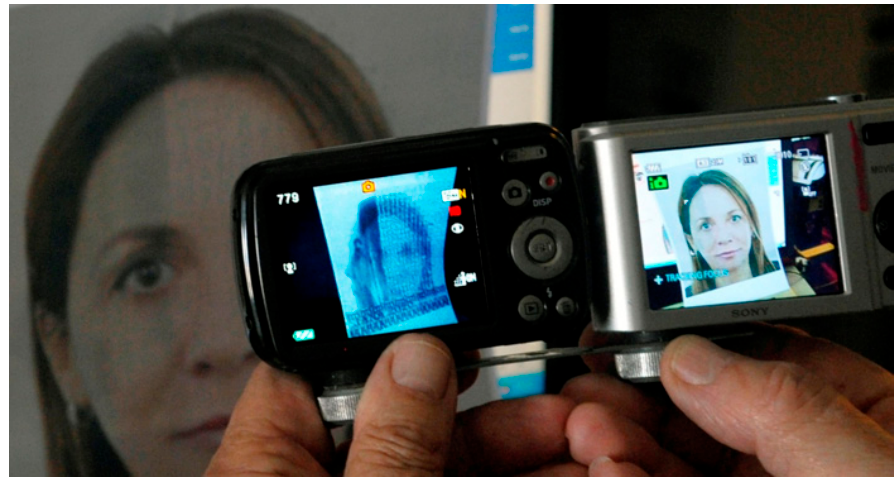
Figure 1. Print studied with a ZRGB camera (Z blockage at 1000 nm and in the visible spectrum; blockade at 400 nm).